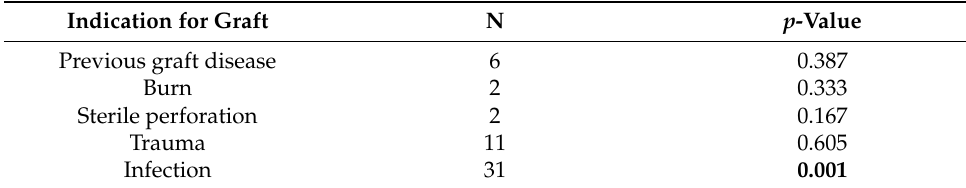
Table 2. Improvement in VA and etiology.